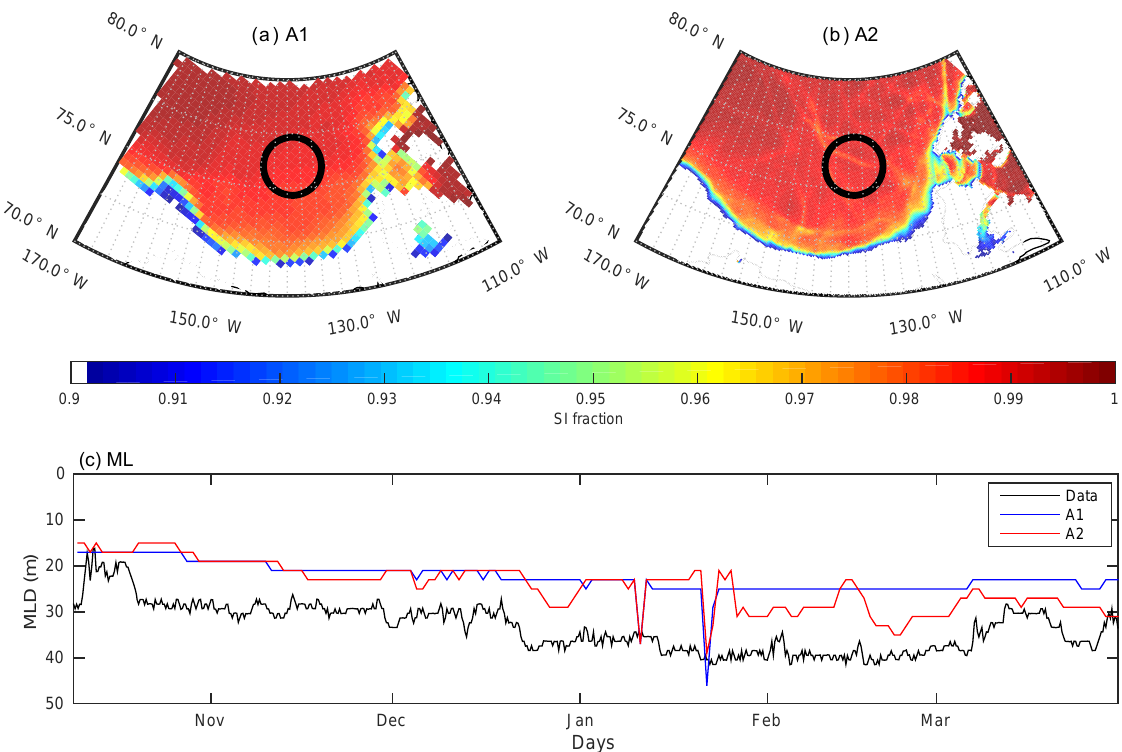
Figure 8. Sea ice cover higher than 0.9 with gray circle marking the area of ITP operation for (a) 36km (A1) and (b) 9km(A2) horizontal resolution of the model. A2 captured the ice opening and resulting mixed-layer change while this phenomenon has been averaged out by a (c) coarse-resolution model observed and simulated evolution of mixed-layer depth on the path of